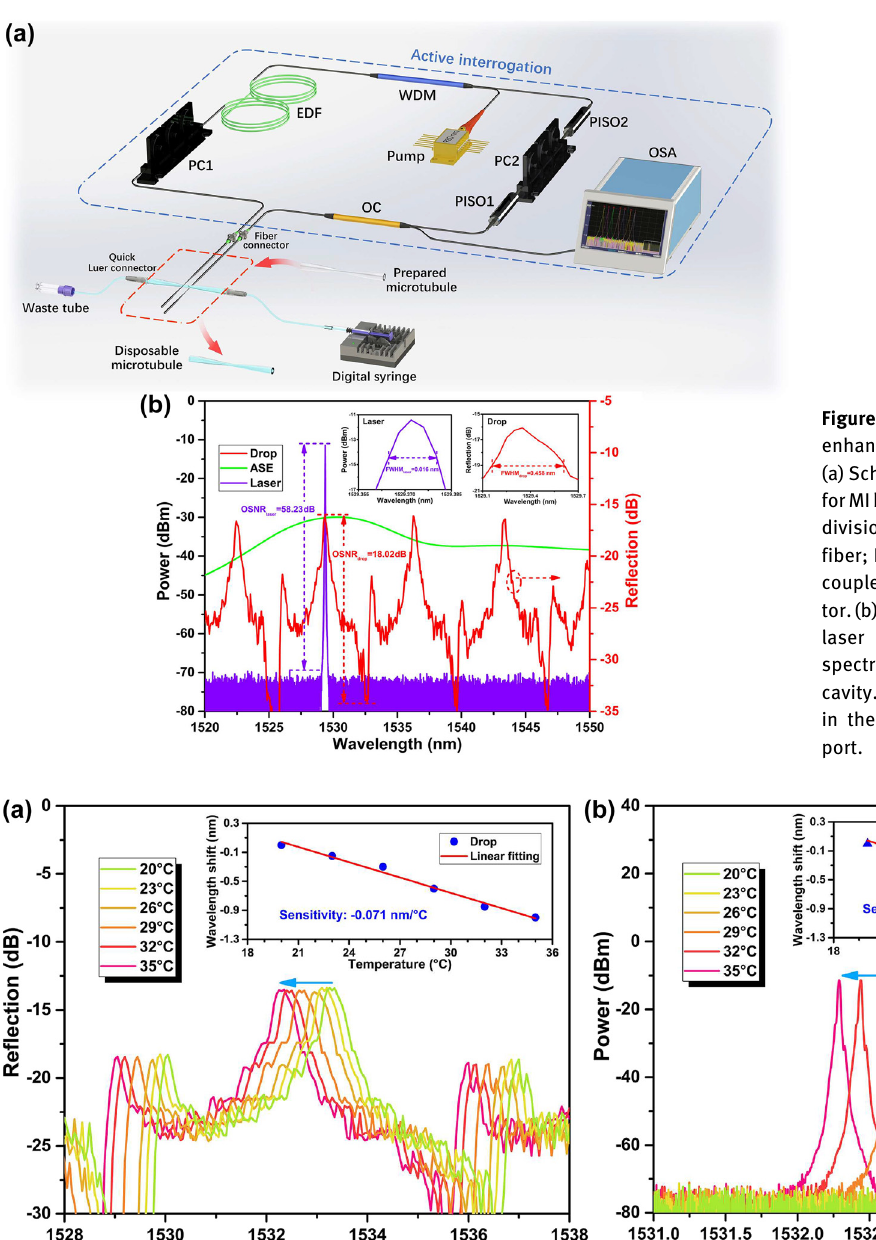
Figure 7: Spectral evolutions of (a) the drop port reflection and (b) the output sensing laser at different temperatures. Insets: temperature sensitivities of peak